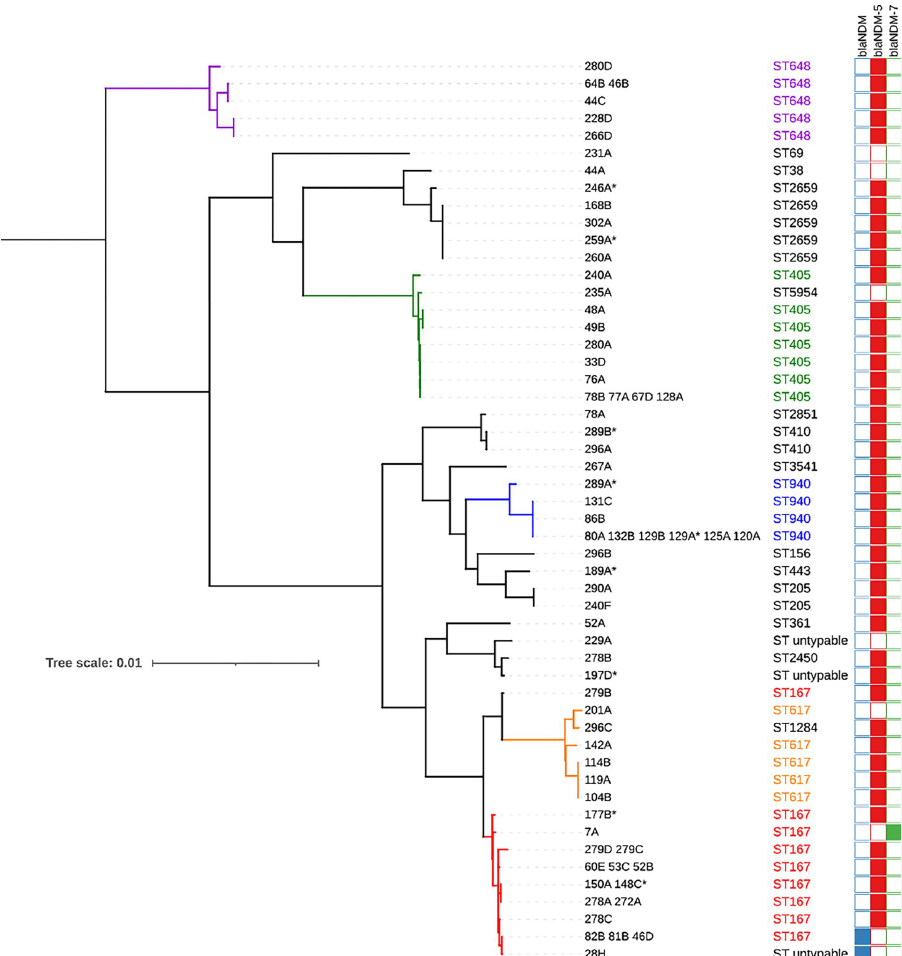
Fig 8. Phylogenetic tree of E . coli . � : hospital-associated isolates. The dendrogram showing the phylogenetic relationship between community-acquired and hospital-associated E . coli .